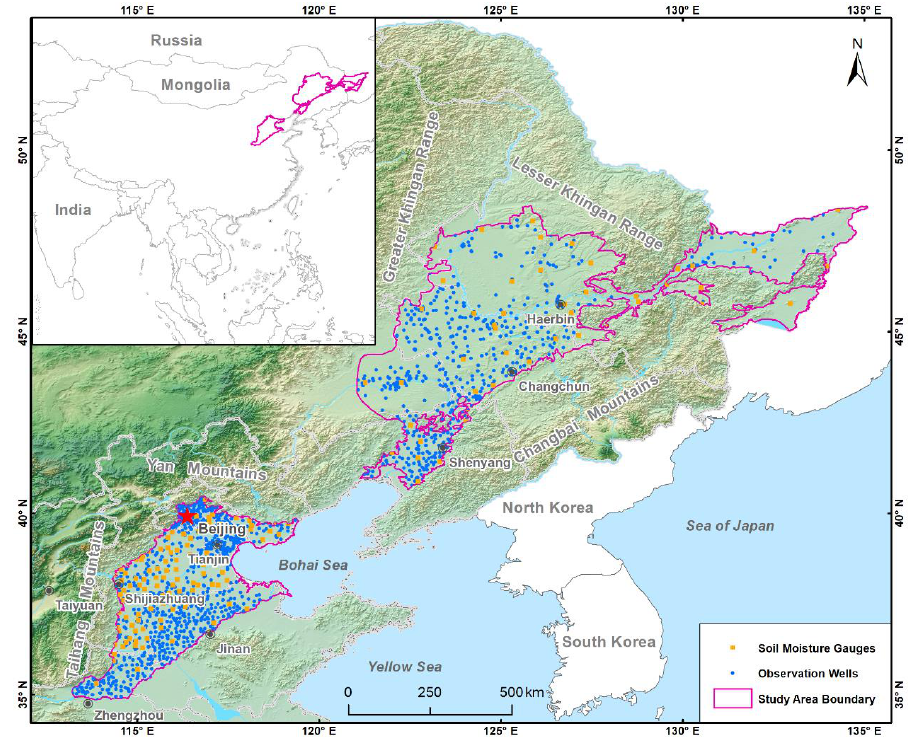
Figure 1. Study area and distribution of in situ soil moisture and groundwater level (GWL) observations.